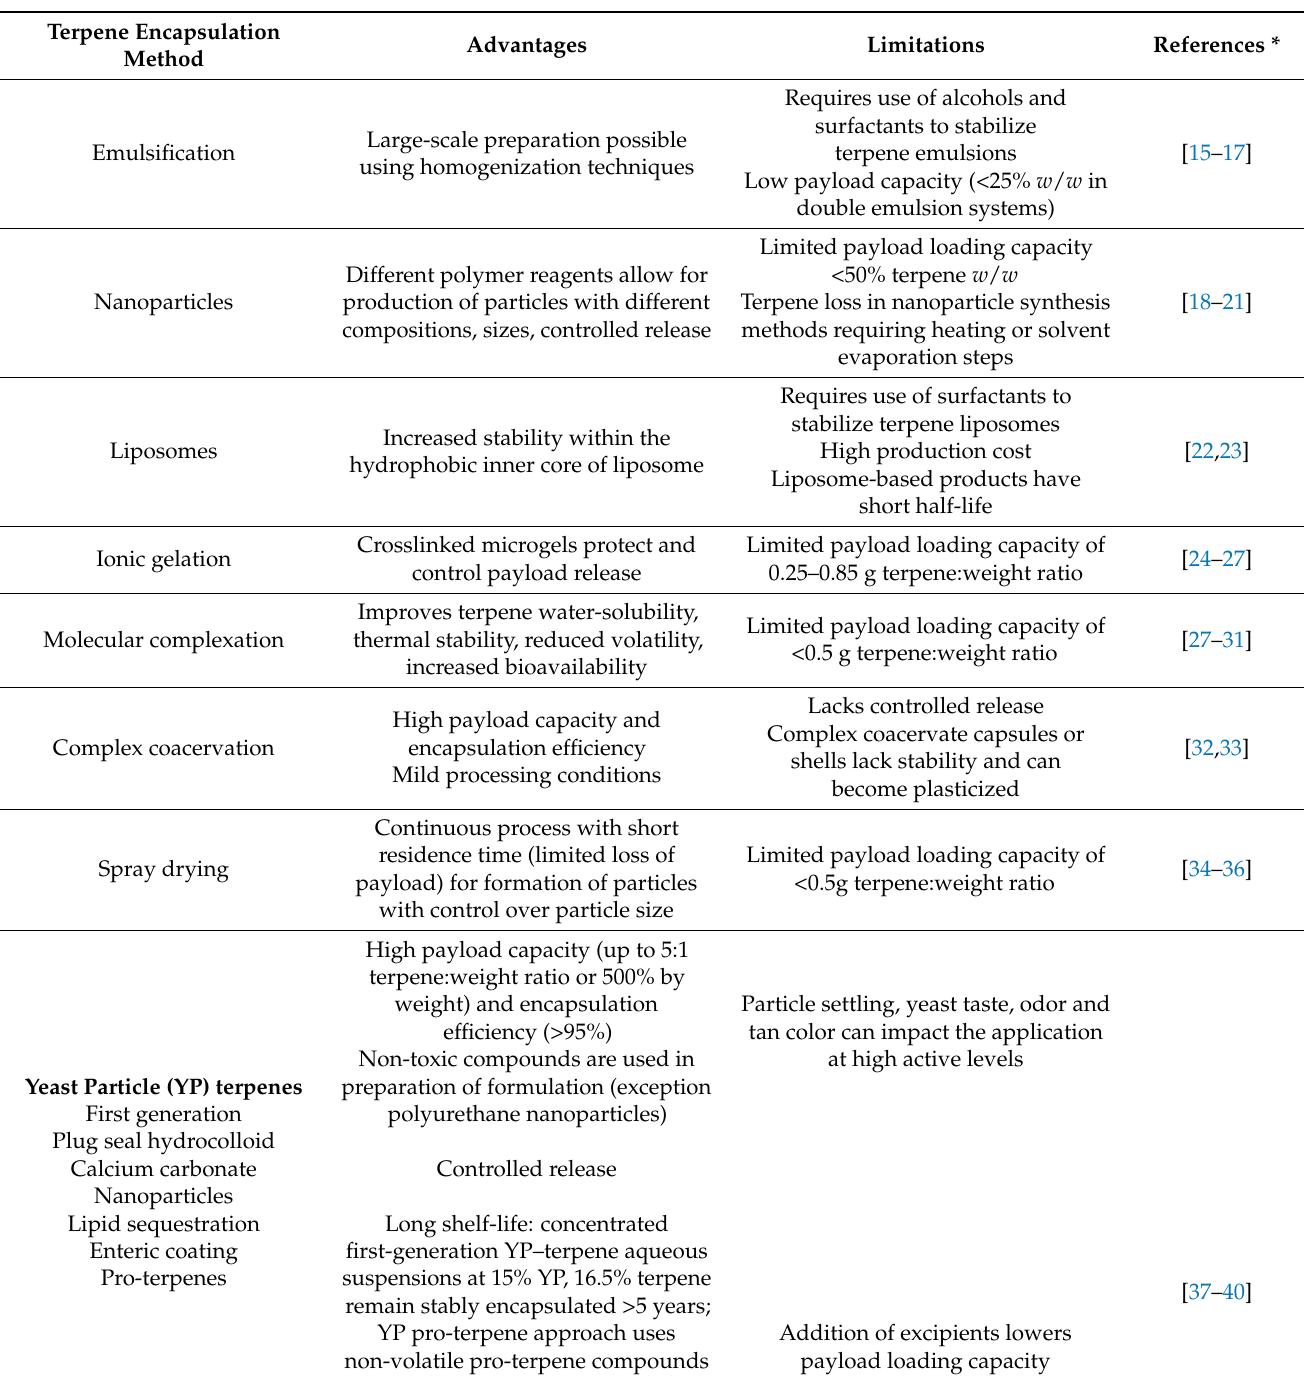
Table 1. Encapsulation methods that can be used to prepare terpene and essential oil